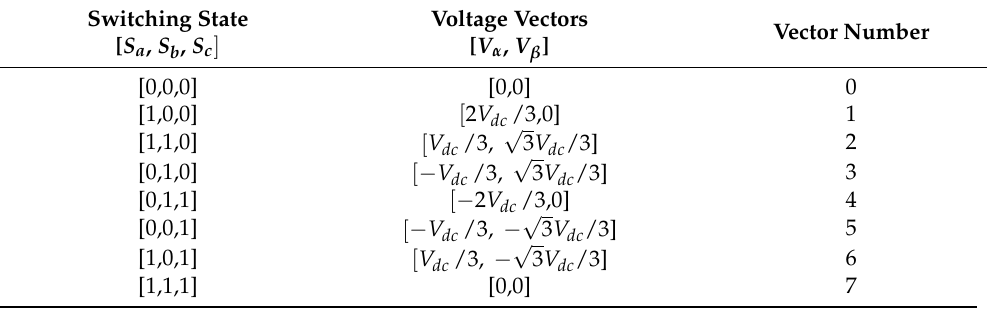
Table 1. Voltage vectors of the three-phase